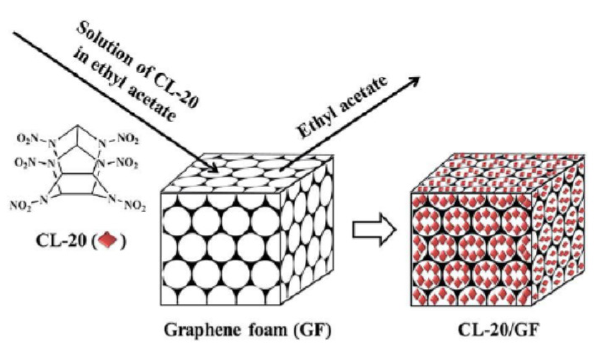
Figure 10. Schematic diagram of the production of